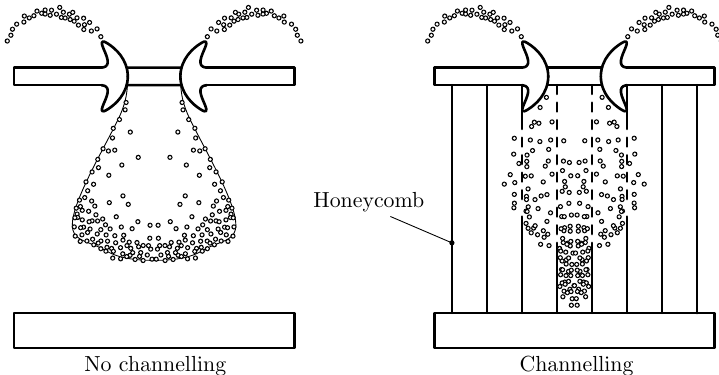
Figure 3. Illustration of the channelling effect on honeycomb core Whipple shields: without honey- comb core ( left ) and with honeycomb core ( right ).